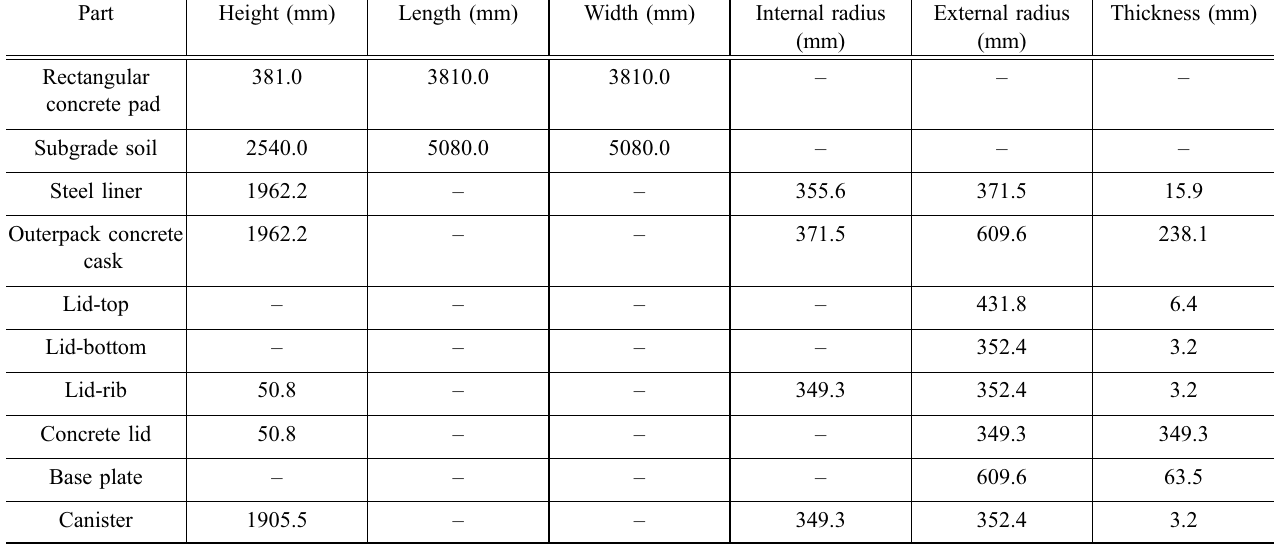
Table 2 Dimensions of 1/3-scale cask used in tip-over impact simulations.